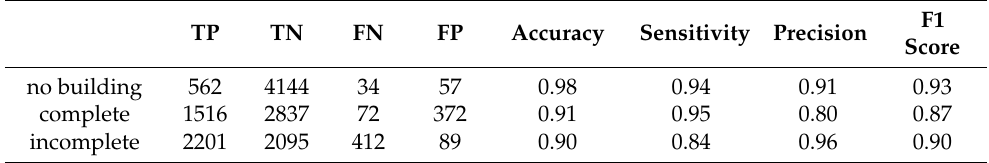
Figure 4. Examples for mismatches between volunteer and expert assessment: ( a ) Tasks predicted as complete, true class is incomplete; ( b ) Tasks predicted as incomplete, true class is complete; ( c ) Tasks predicted as no building, true class is incomplete; ( d ) Tasks predicted as incomplete, true class is no building. Shown are MapSwipe tiles with the OSM building footprints (blue) overlaid. Table 3. Classification performance metrics for the completeness classification task. TP, TN, FN and FP are the total number of tiles that were classified as true positives, true negatives, false negatives and false positives, respectively, by the aggregated voting of the volunteers.